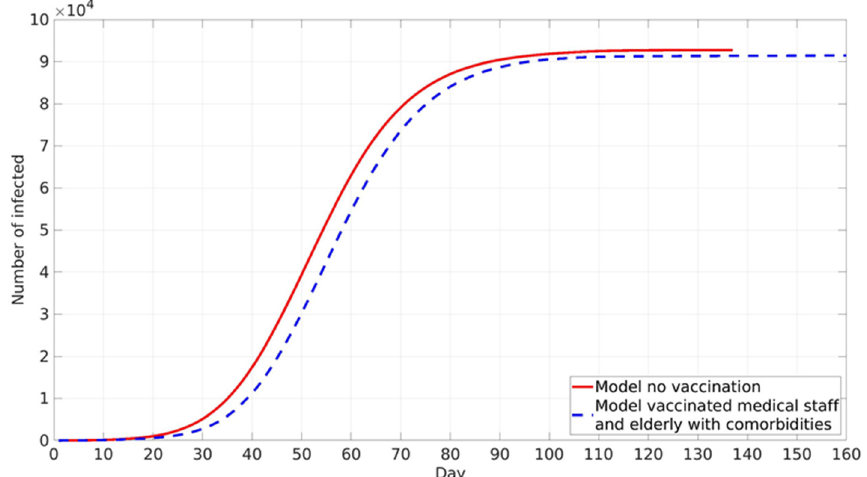
Figure 5. The model predicted cumulative numbers of infected cases: without vaccination—red line, vaccinated healthcare workers in COVID system and elderly population in nursing homes—blue dotted line.